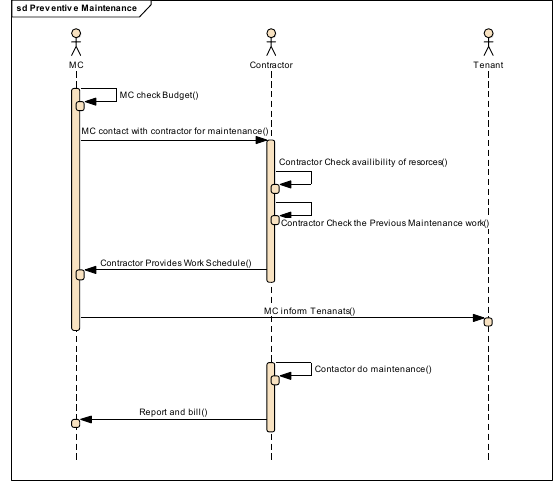
Figure 8. Sequence Diagram for Preventive